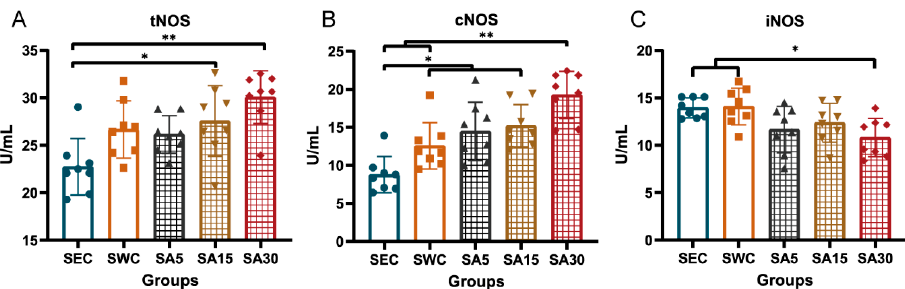
Figure 5. Effects of astaxanthin on NOS activity in plasma in swimming training mice. ( A ) exhibits tNOS levels among different groups, ( B ) exhibits cNOS levels among different groups, and ( C ) presents iNOS level among different groups. Values are means ± SD ( n = 8). The symbol * indicates a significant difference at p < 0.05, and ** indicates a significant difference at p < 0.01.